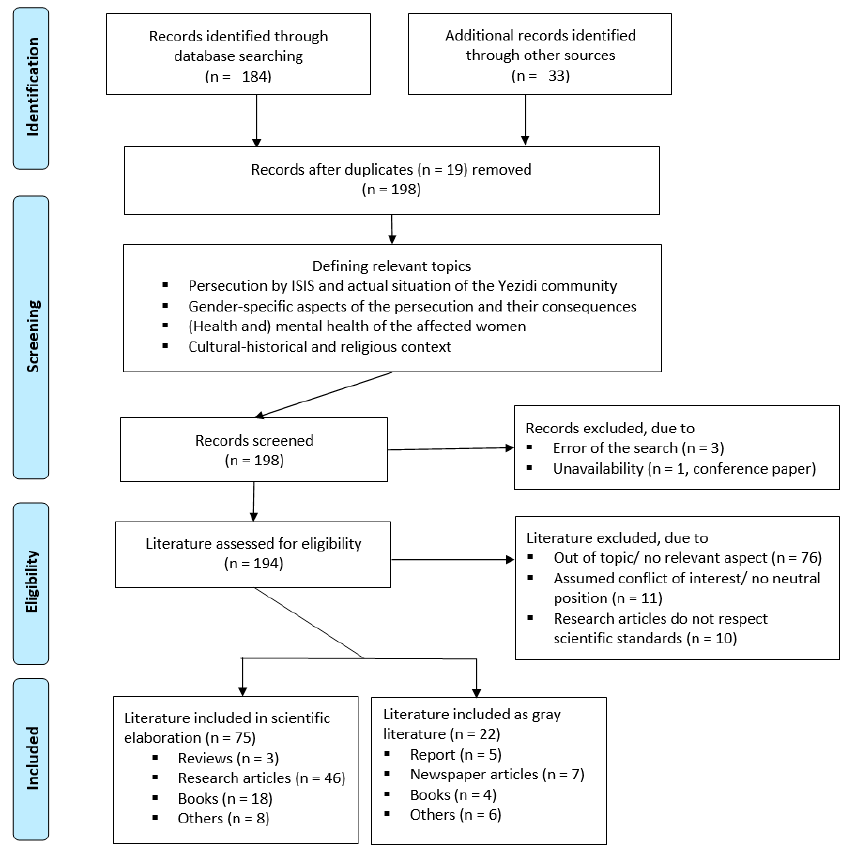
Figure 1. Flow diagram for the selection of literature.